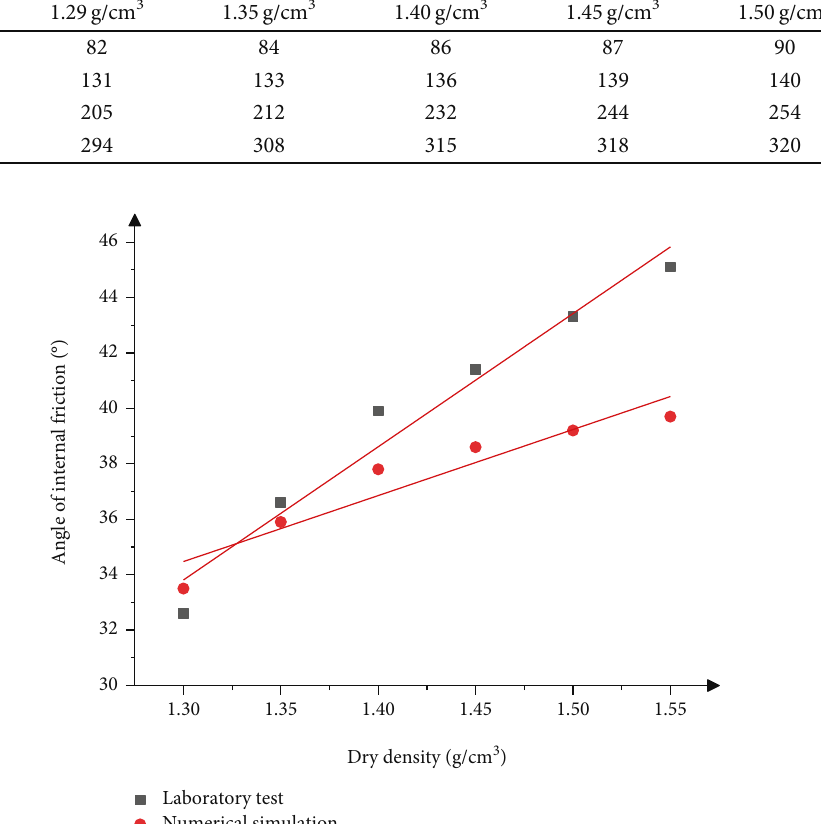
Figure 9: Internal friction angle-dry density curve of indoor test and numerical simulation test.